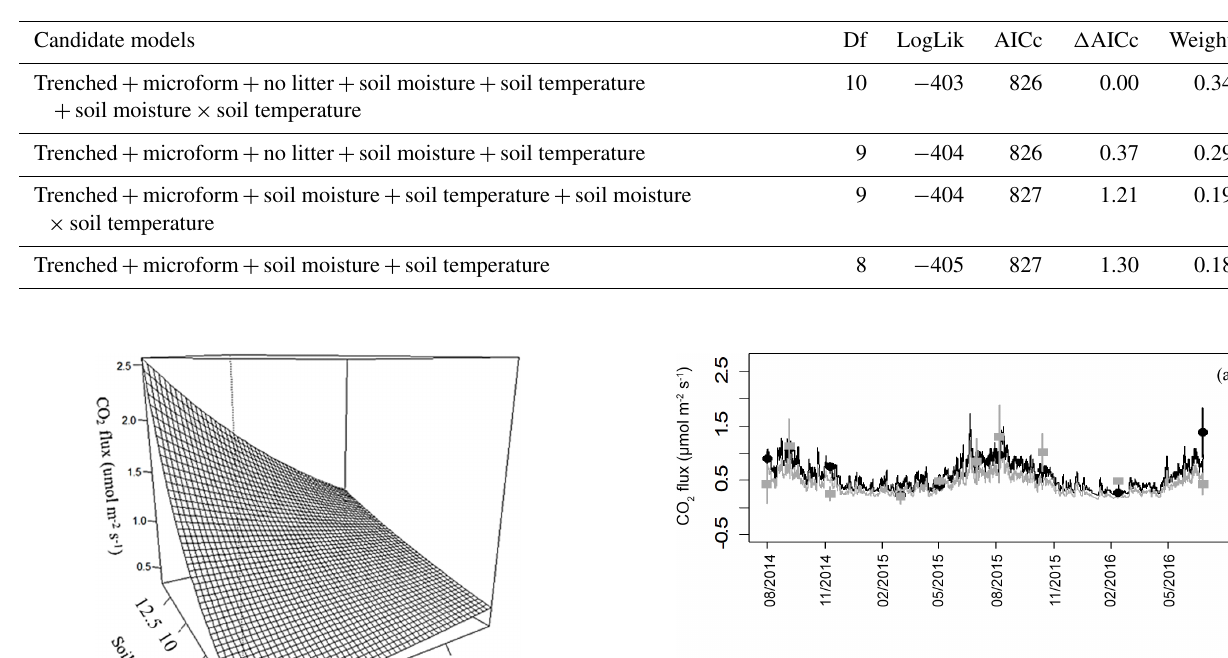
Table 2. Model selection summary, showing the four best-ranked models with a delta AICc of less than 2. Models are ranked by AICc and weight, where higher weighted models have more statistical support. Df is the degrees of freedom, LogLik is the log likelihood and (cid:49) AICc is the difference in AICc to the top model.